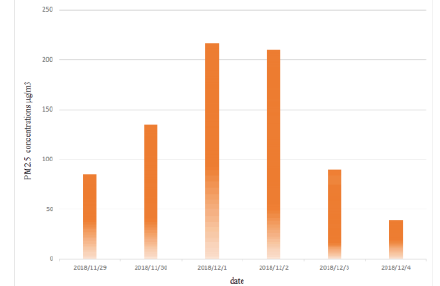
Figure 9. PM2.5 concentrations histogram of Beijing during the heavy pollution process from 29 November to 3 December 2018.